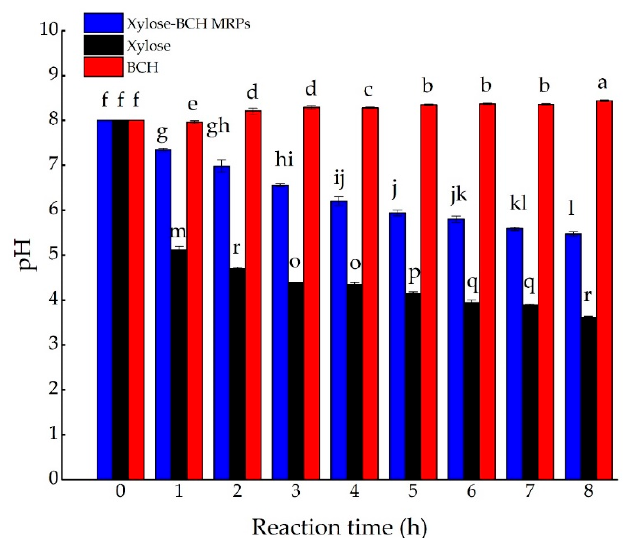
Figure A1. Effect of Maillard reaction time on the pH of xylose–bovine casein hydrolysate (BCH) MRPs at 100 °C. The standard deviation is showed by error bars. Data points with diverse letters are significantly different ( p < 0.05).